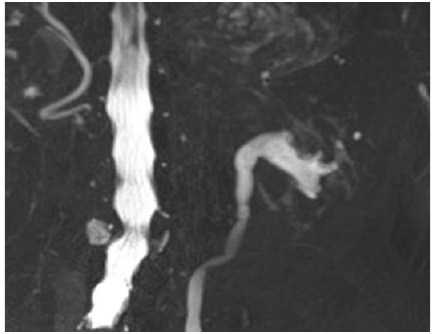
Figure 8: T2-weighted MR urography demonstrates a mass at the upper pole of the left kidney directly invading the renal pelvis.